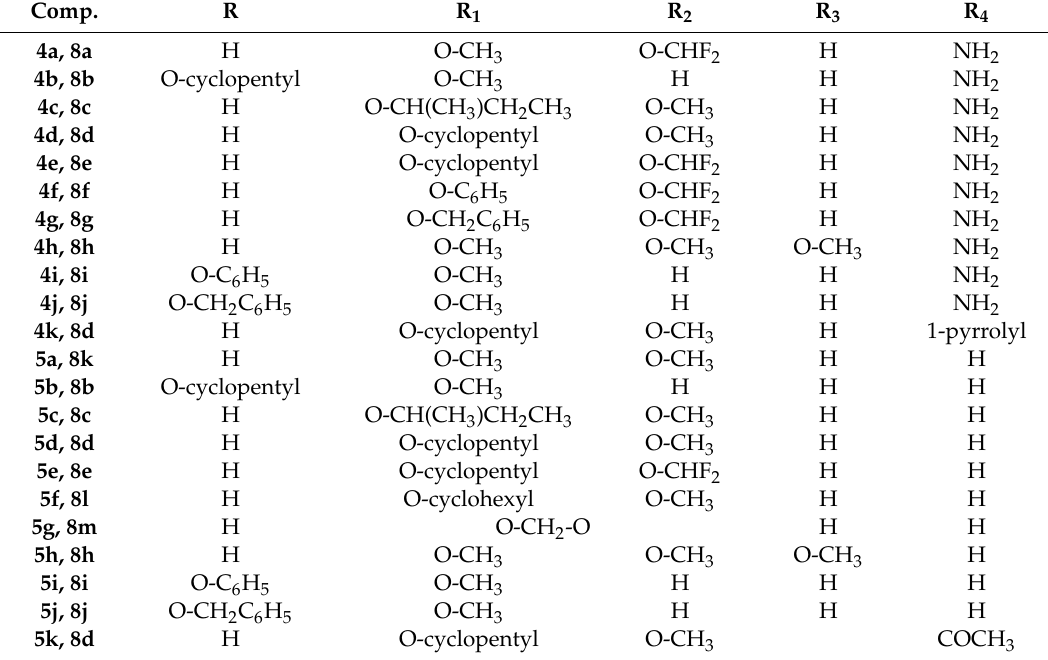
Table 1. Decorations on the hybrid structures 4a – k , 5a – k and the benzaldehydes 8a – m used for their